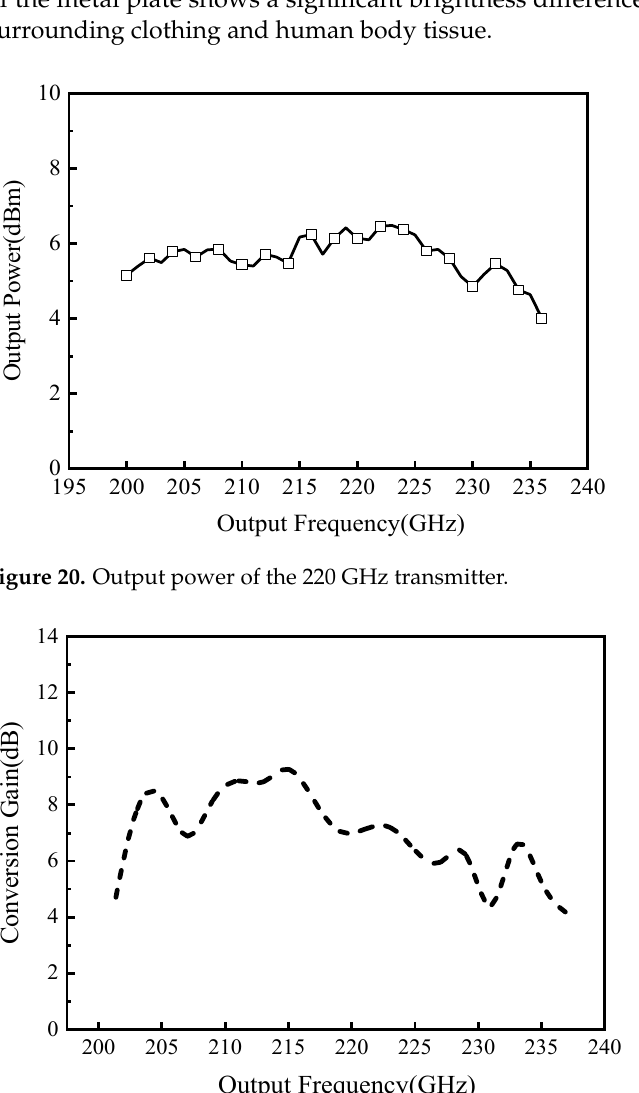
Figure 19. Photograph of the fabricated 200–240 GHz remote sensing system for imaging applications: ( a ) transmitter channel; ( b ) receiver channel.